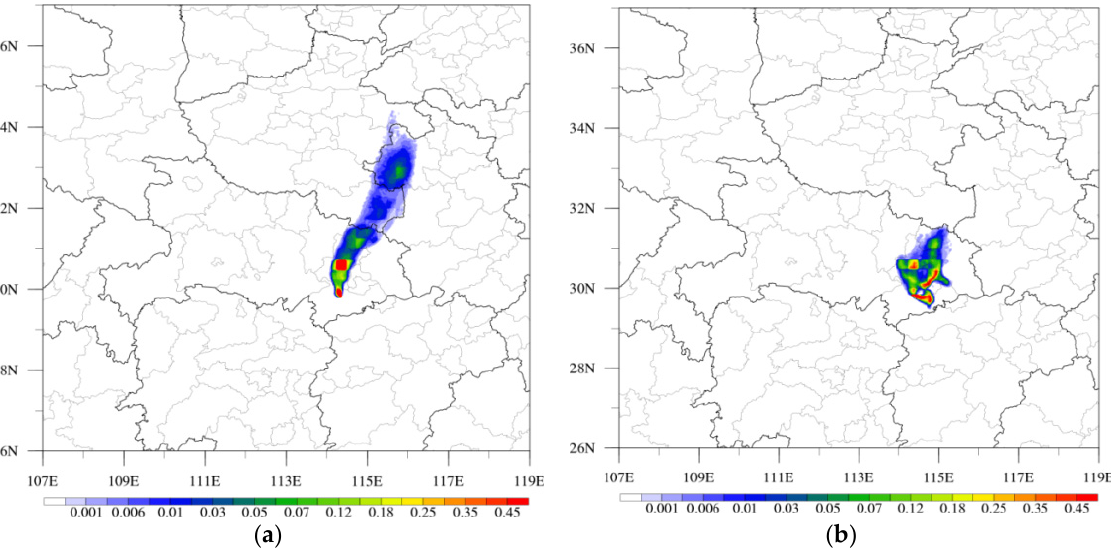
Figure 8. Spatial distribution of the contribution rates of surrounding atmospheric pollution sources to the surface PM 2.5 concentration at Xianning station on ( a ) 5 and ( b ) 6 January 2019 by the FLEXPART-WRF model.